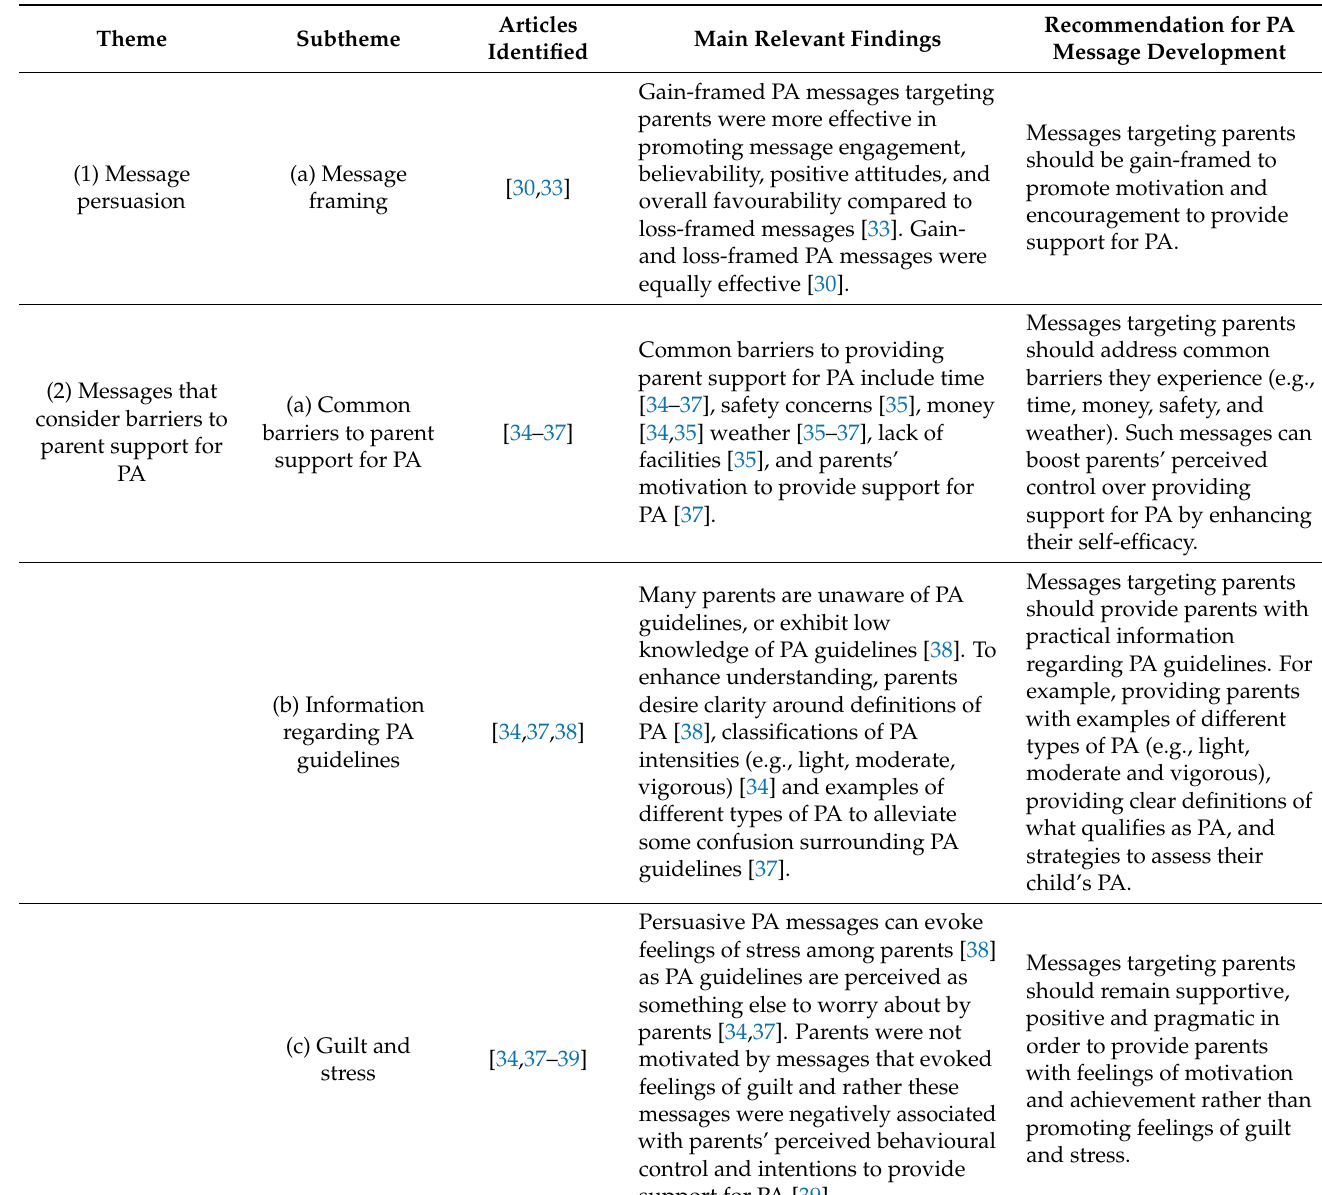
Table 2. Literature regarding the development of physical activity messages targeting